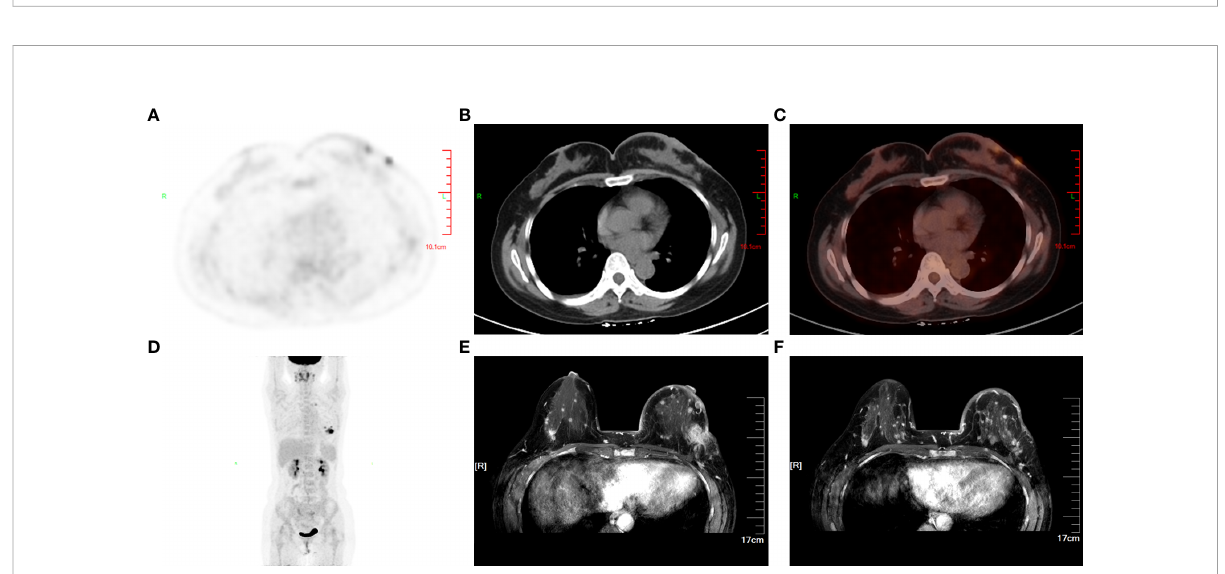
FIGURE 2 Primary lesion and invasive metastasis in the breast. PET/CT (A – D) revealed multiple masses with increased glucose metabolism in the lateral quadrant of the left breast as well as nodules with slightly increased glucose metabolism in the lateral quadrant of the right breast, which indicated aggressive invasion of the primary tumor on the left. MRI (E, F) in axial sections of the patient ’ s breast before chemotherapy showed the primary lesion in the left breast and multiple contralateral breast